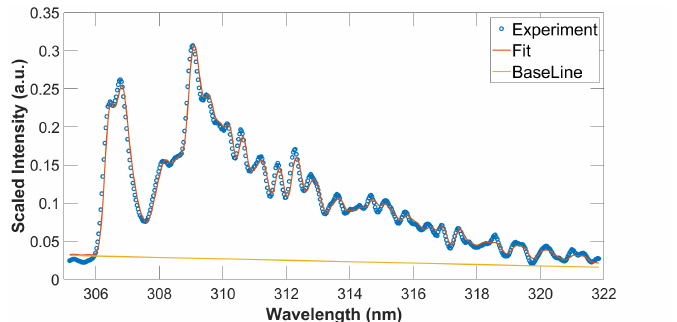
Figure 4. Measured and fitted OH spectra, T = 3390 K, spectral resolution: 0.35 nm. The blue circles and red line indicate experimental and fitted data, respectively. The straight line shows the fitted base line that represents an assumed, linearly varying